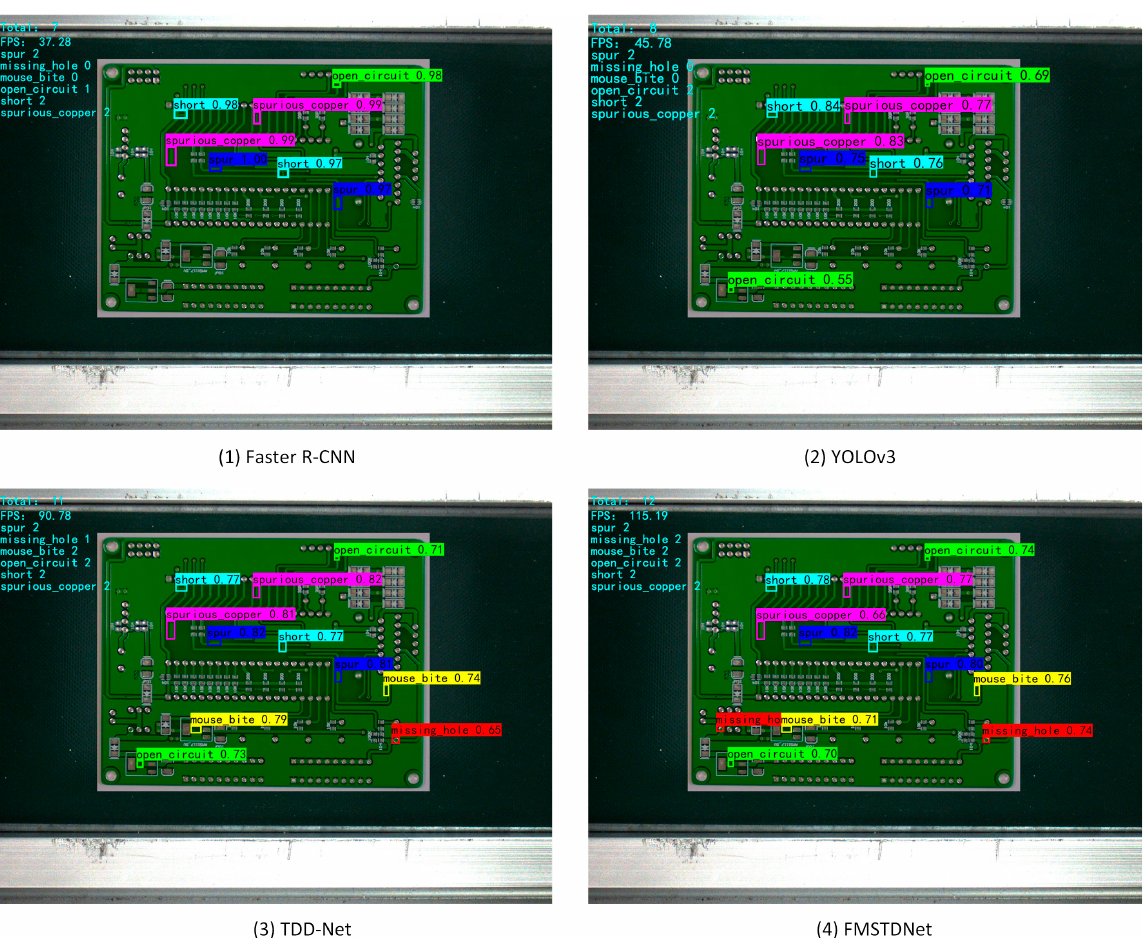
Figure 7. Comparison of detection performance of FM-STDNet model with Faster R-CNN, YOLOv3, and TDD-Net models on 20 m/s mobile PCB.